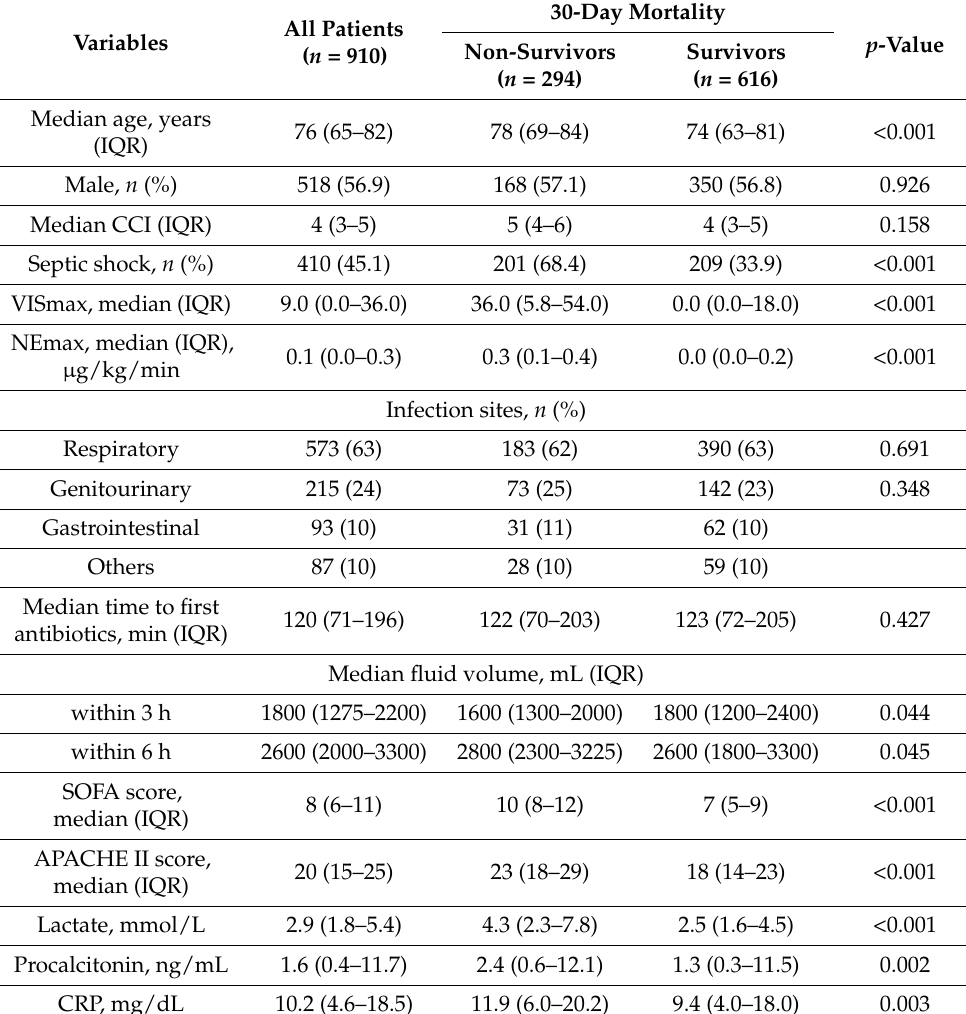
Table 1. Baseline patient characteristics according to 30-day mortality.